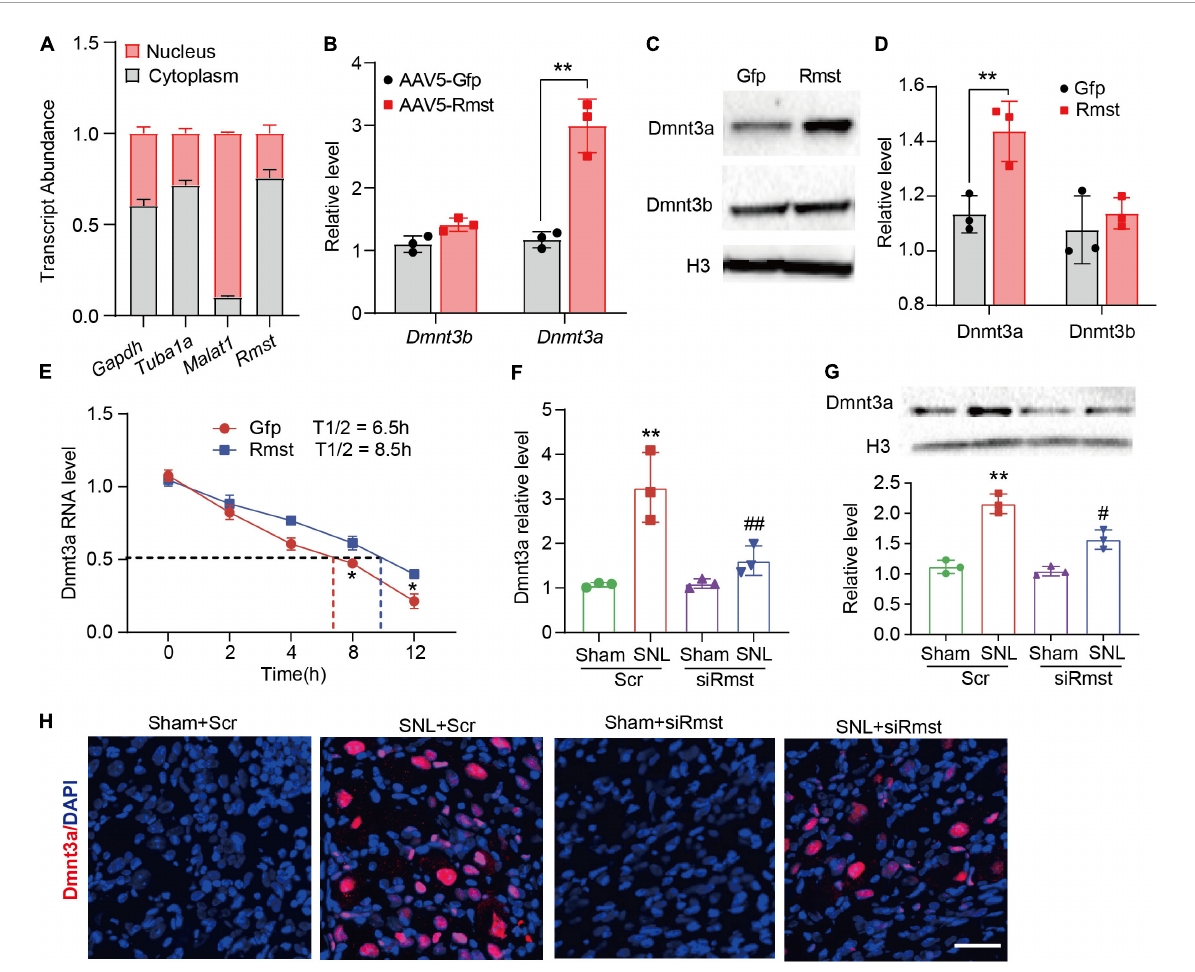
FIGURE5 Dorsal root ganglion (DRG) rhabdomyosarcoma 2-associated transcript ( Rmst ) participated in the nerve damage induced Dnmt3a expression by stabilizing Dnmt3a mRNA. (A) Transcript abundance of cytoplasmic and nuclear RNA fractions for Gapdh mRNA, Tuba1a mRNA, Malat1 mRNA, and Rmst mRNA from mouse DRGs. n = 3 mice. (B) Level of Dnmt3a and Dnmt3b mRNA expression in DRG neuron with AAV5-Rmst. T -test was used for statistic analysis. ** P < 0.01 versus AAV5-Gfp group. (C,D) Dnmt3a and Dnmt3b protein expression in DRG neuron with AAV5-Rmst. T -test was used for statistic analysis. ** P < 0.01 versus AAV5-Gfp group. (E) Primary DRG neurons with the treatment of ActD (5 µ g/mL) at multiple time point as shown were treated with AAV5-Rmst or AAV5-Gfp. n = 3 biological repeats. * P < 0.05 versus AAV5-Rmst group. (F,G) Levels of Dnmt3a mRNA (F) and protein expression (G) in ipsilateral L4 DRGs of SNL mice pre-received with siRmst or Scr. n = 12, one-way ANOVA followed by post-hoc Tukey test, ** P < 0.01 versus Sham + Scr group and # P < 0.05, ## P < 0.01 versus SNL + Scr group. (H) Immunostaining for the ipsilateral L4 DRGs showed Dnmt3a protein expression in mice post-SNL and pre-delivered with siRmst or Scr. Scale bar = 40 µ